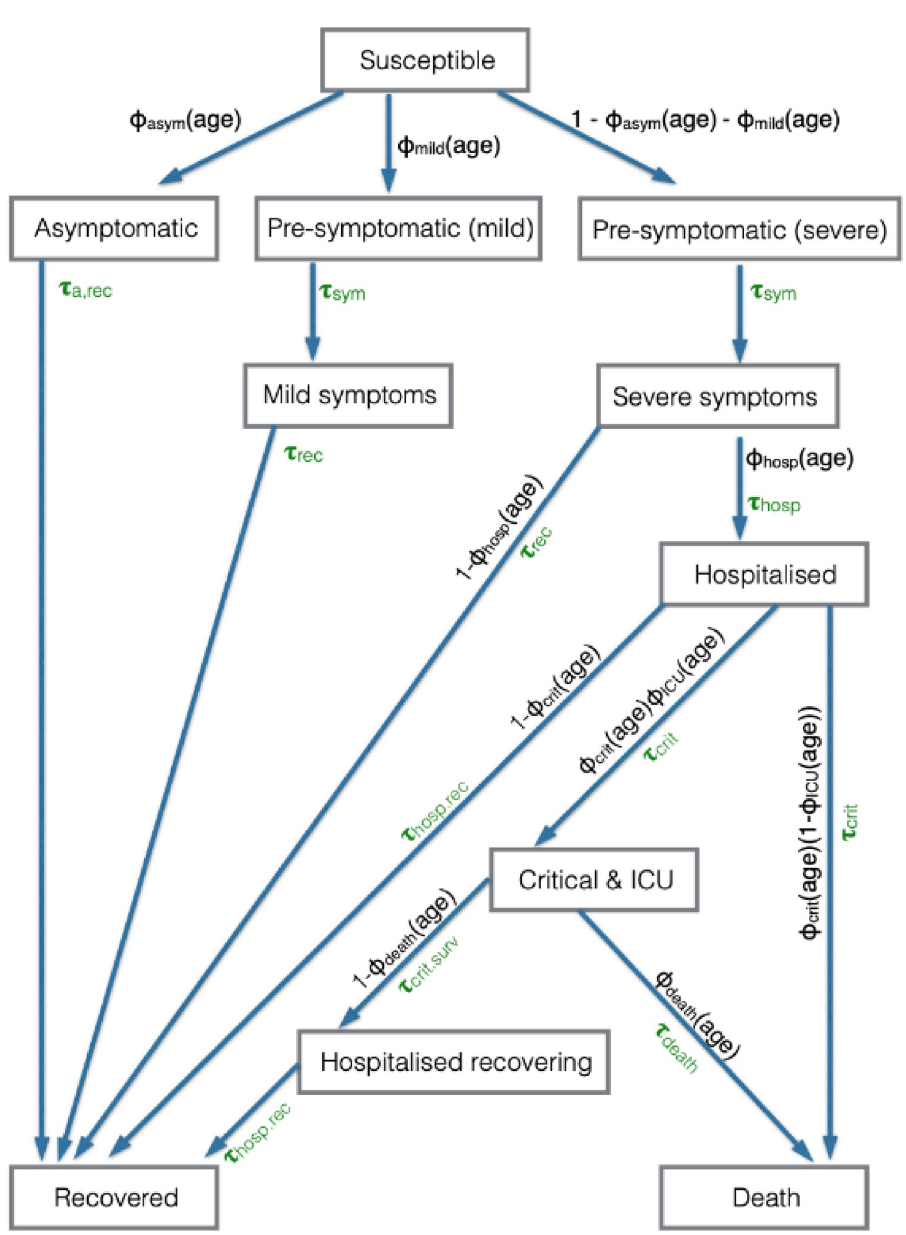
Fig 6. Schematic of infection and disease transitions within OpenABM-Covid19. The disease status of an individual, and the probability and time distribution of transitions. The F xxx (age) variables are the probability of transition to a particular state, when the individual can progress to more than one state within the model, where the probability depends upon the age of the individual. The τ xxx are the gamma distributed variables of the time taken to make the